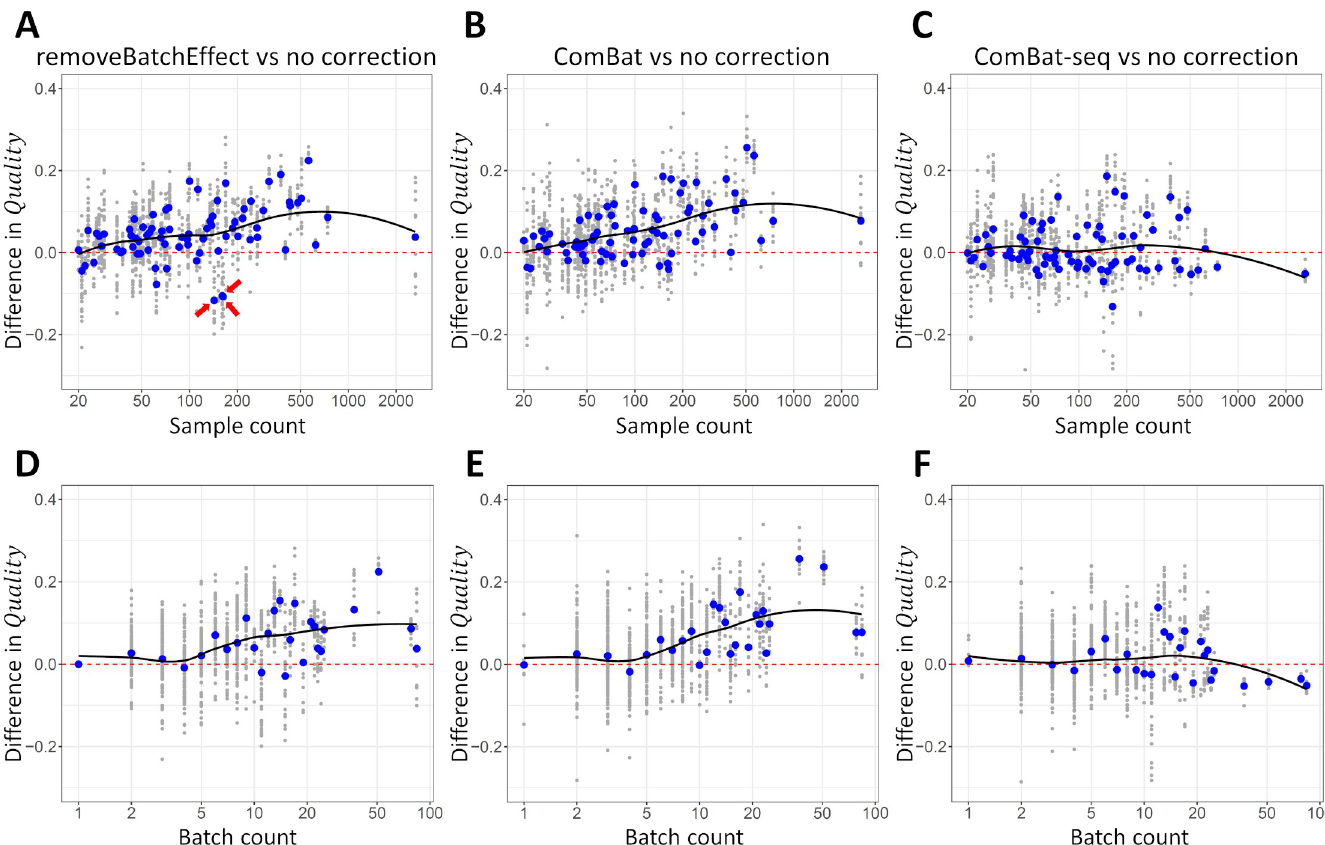
Fig 4. The number of samples and batches affect the advantage of batch effect correction. (A-C) Difference in quality of co-expression networks based on data with and without treating batch effects in function of sample count, for data treated with removeBatchEffect (A) , ComBat (B) , and ComBat-seq (C) . Positive values indicate an increase in quality in the batch-treated networks. (D-F) Difference in quality of co-expression networks based on data with and without treating batch effects in function of the number of batches in each dataset, for removeBatchEffect (D) , ComBat (E) , and ComBat-seq (F) . The average difference in quality is shown in blue for each sample count and for each batch count. A smoothed pattern (loess) is included in each